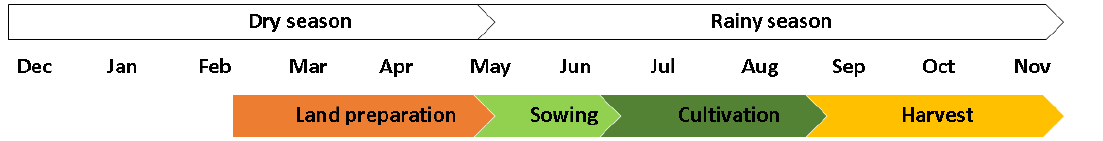
Figure 3. Calendar of seasons and agricultural management. The study region contains two clearly distinct seasons with crop cultivation during the rainy season and land preparation at the end of the dry